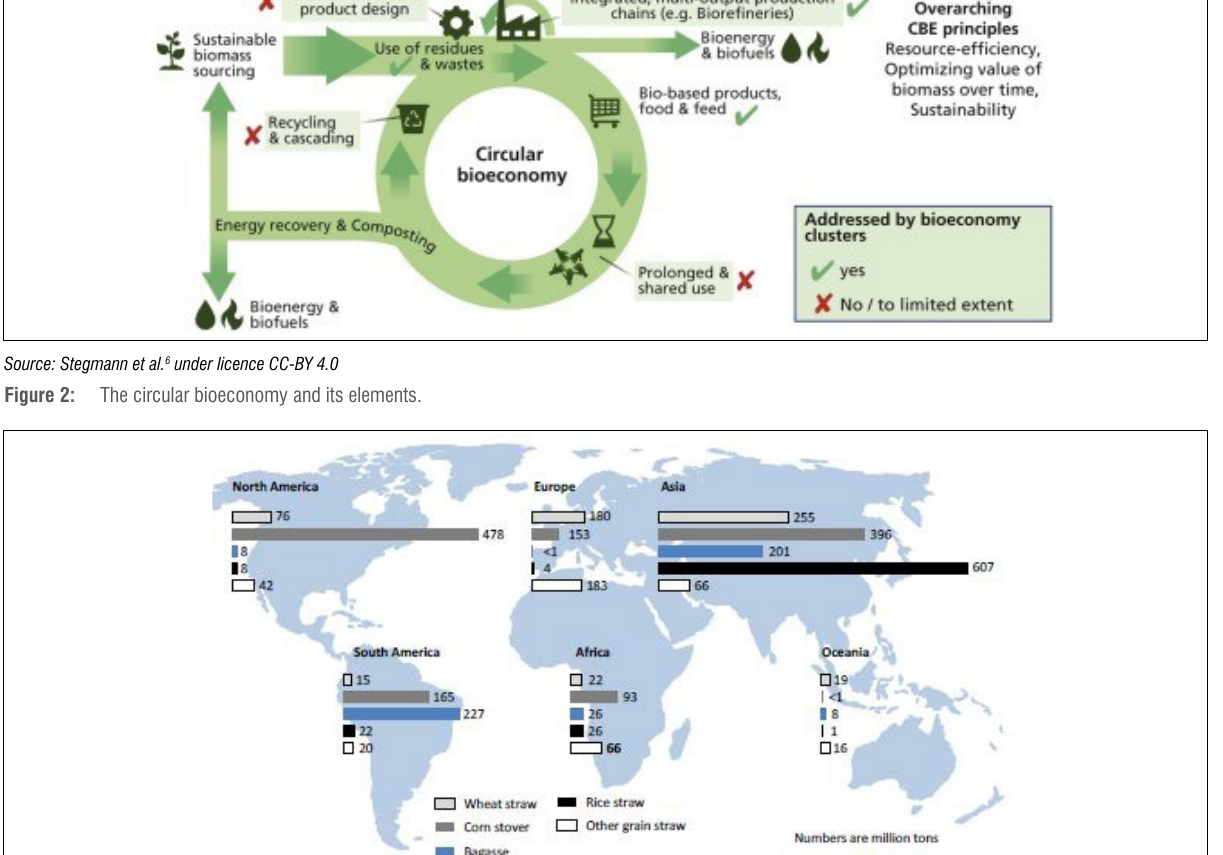
Figure 3: Global estimates of lignocellulosic waste materials available for bioproduction. The numbers represent millions of tons.